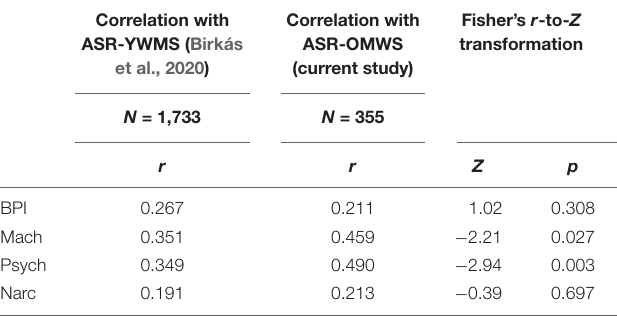
TABLE 3 | Pearson’s correlations between acceptance of sugar relationships and personality traits (Sample 2). Correlation with ASR-YWMS